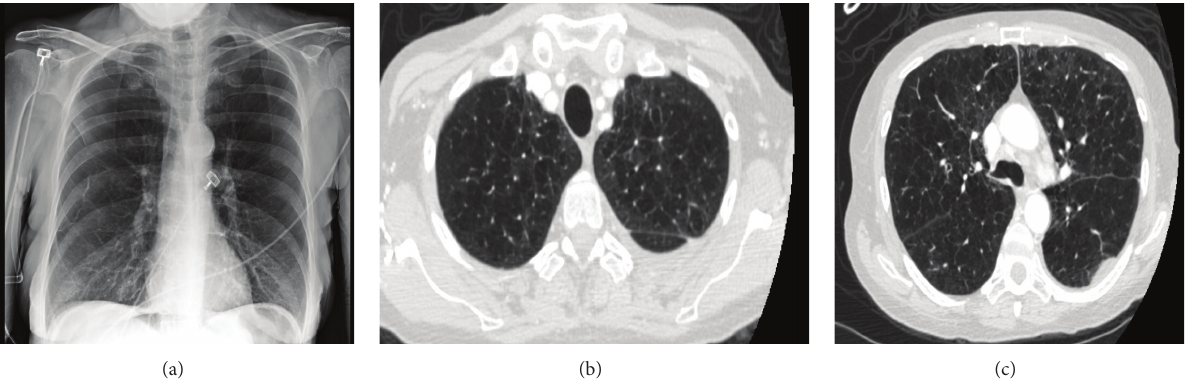
Figure 1: Chest X-ray and chest CT findings in Case 1 . Chest X-ray findings on day of admission demonstrating hyperinflated lung fields. Chest CT findings 10 months before case presentation demonstrating severe centrilobular